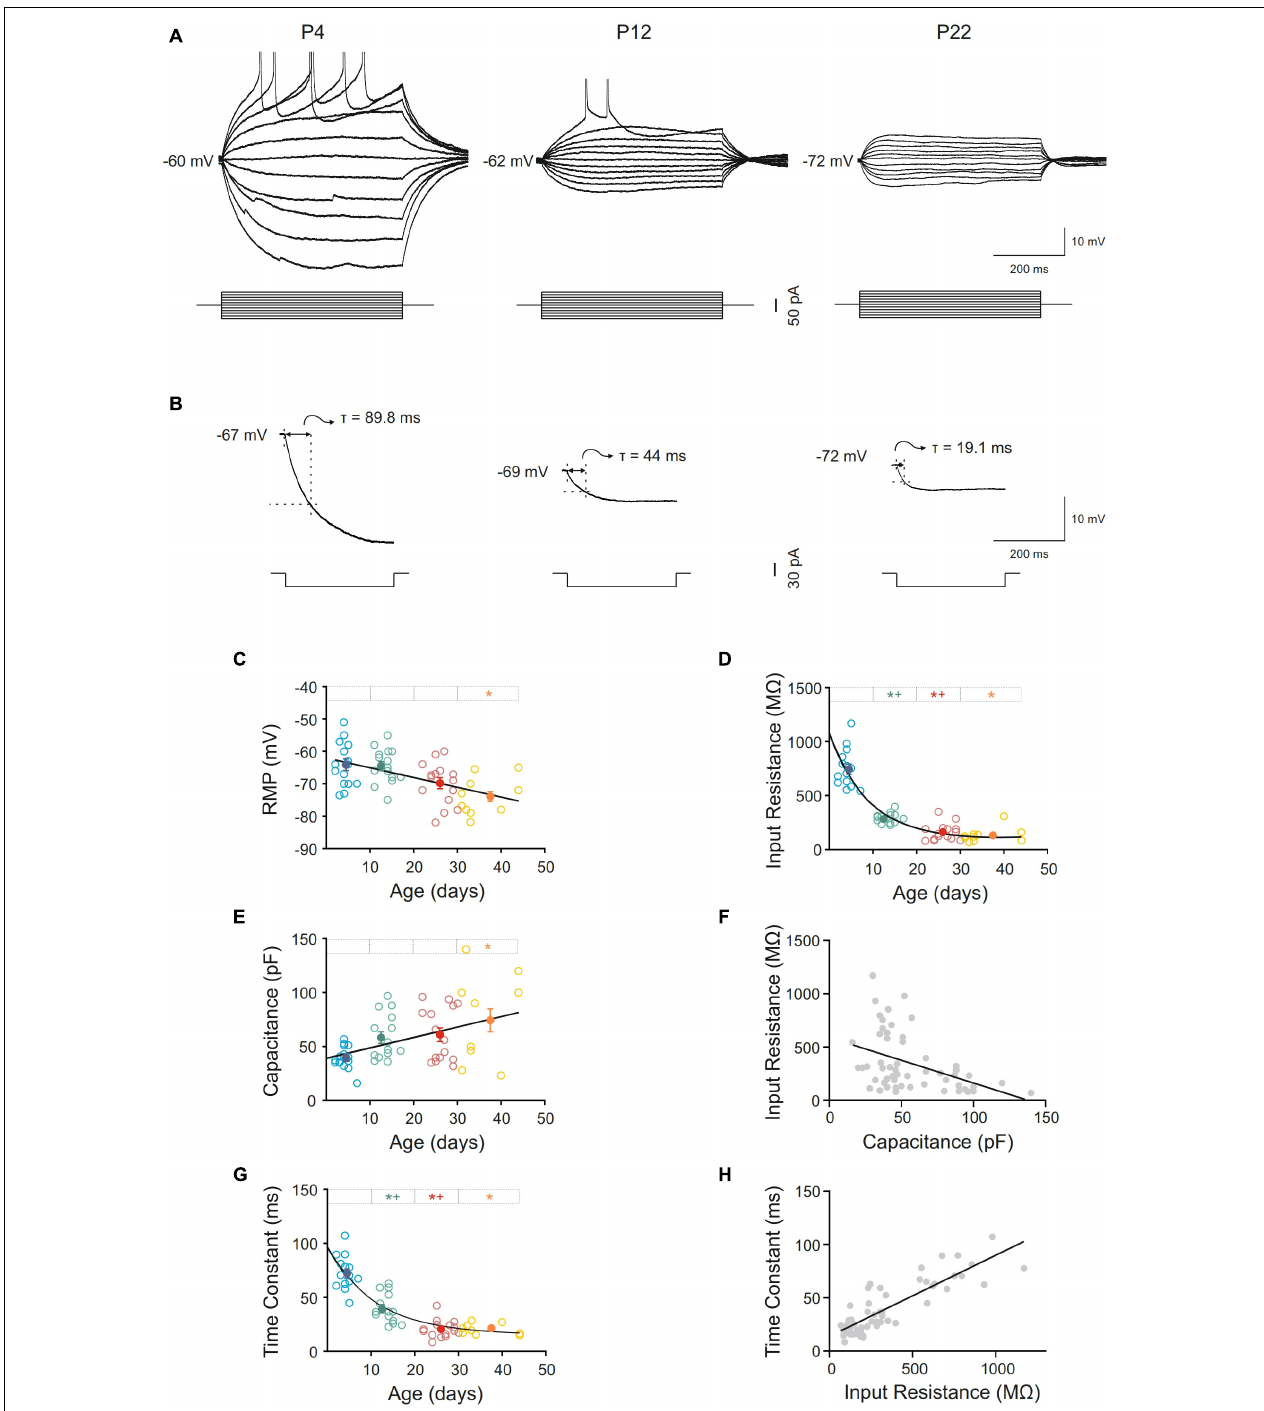
FIGURE 2 | Postnatal development of passive membrane properties of motor cortex pyramidal neurons. (A) Membrane voltage responses to depolarizing and hyperpolarizing current pulses in representative neurons of different ages. (B) Average ( n = 10) of the membrane voltage response to a hyperpolarizing current pulse (300 ms, –20 pA) in the representative neurons show in (A) . (C–E,G) Scatter plots showing the changes in resting membrane potential (RMP) (C) , input resistance (D) , capacitance (E), and time constant (G) as a function of postnatal age. Open symbols represent the raw data, while filled symbols are the means of the four different age groups and their standard errors. Each age group is represented by a color (blue = newborn, n = 15; green = infantile, n = 15; red = young adult, n = 15; yellow = adult, n = 10). An asterisk indicates a significant difference from the newborn group; a cross indicates a difference between adjacent groups. The significance level was established as p ≤ 0.05 (F,H) . Correlation between input resistance and capacitance, r = –0.43; p < 0.0009 (F) and time constant and input resistance, r = 0.86; p < 0.0001 (H) .